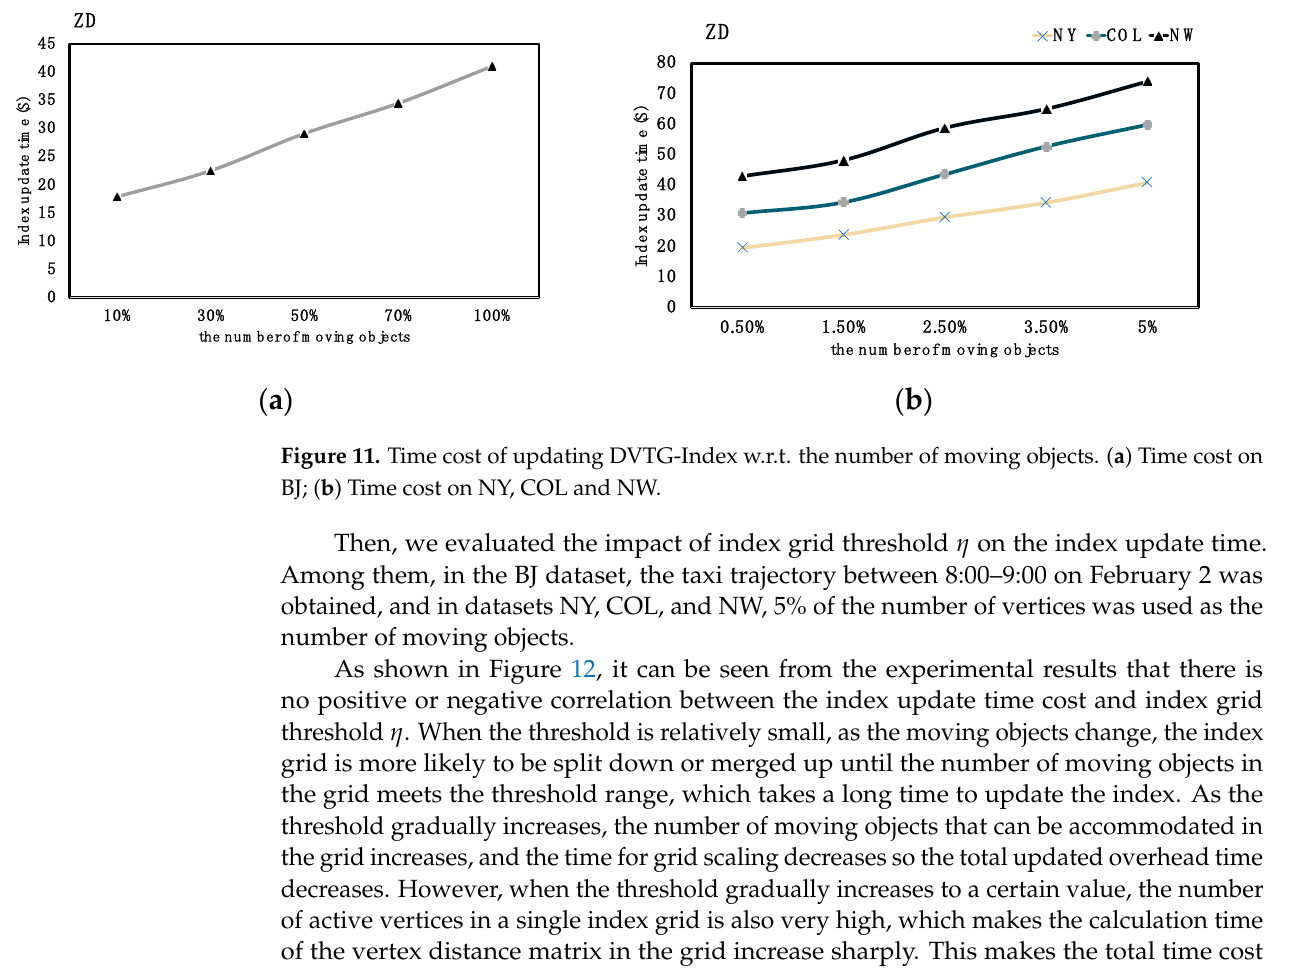
( d ) Figure 10. Comparison of construction time and space costs between baseline algorithms and DVTG-Index. ( a ) Construction time and space costs on BJ; ( b ) Construction time and space costs on NY; ( c ) Construction time and space costs on COL; ( d ) Construction time and space costs on NW. The real-time change in moving objects is one of the difficulties in this study. Our index associated the moving objects with the vertices of the road network index and mapped the changes in the moving objects to the update of the index, which better han- dled this difficulty. When the moving object started to move on the road network, the index update performance also directly affected the performance of subsequent k -nearest